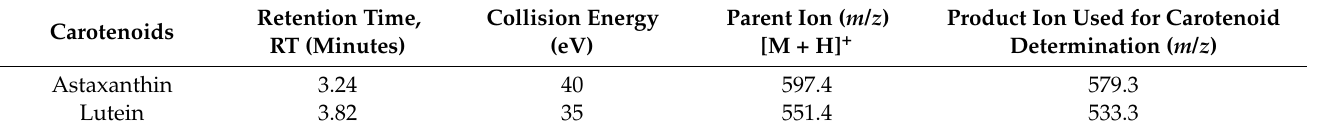
Table 2. Retention times and MS/MS transitions of the examined